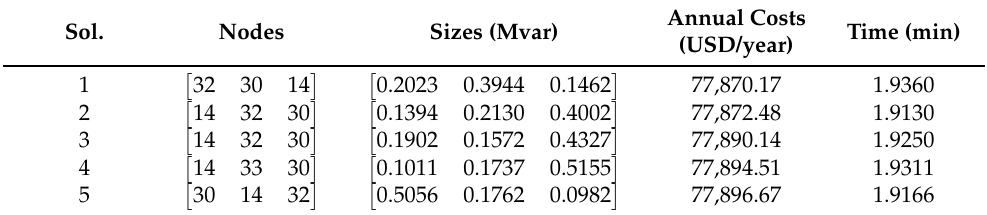
Table 5. Best five solutions found by the proposed solution methodology for the meshed operation